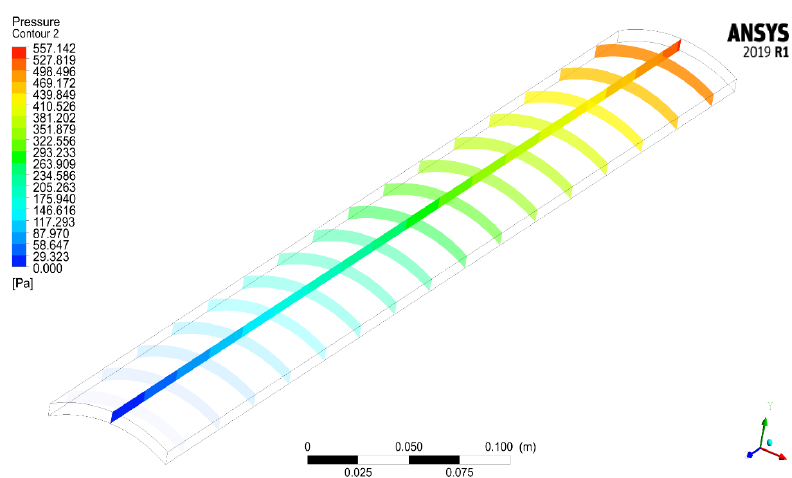
Figure 17. Velocity profile of coolant channel.